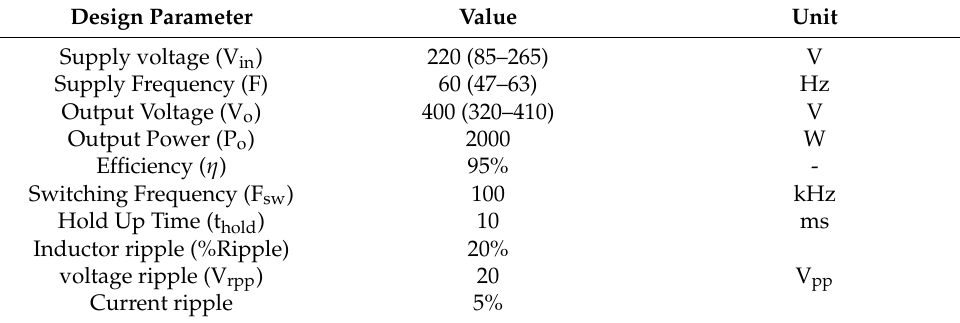
Table 1. The target PFC converters stage design